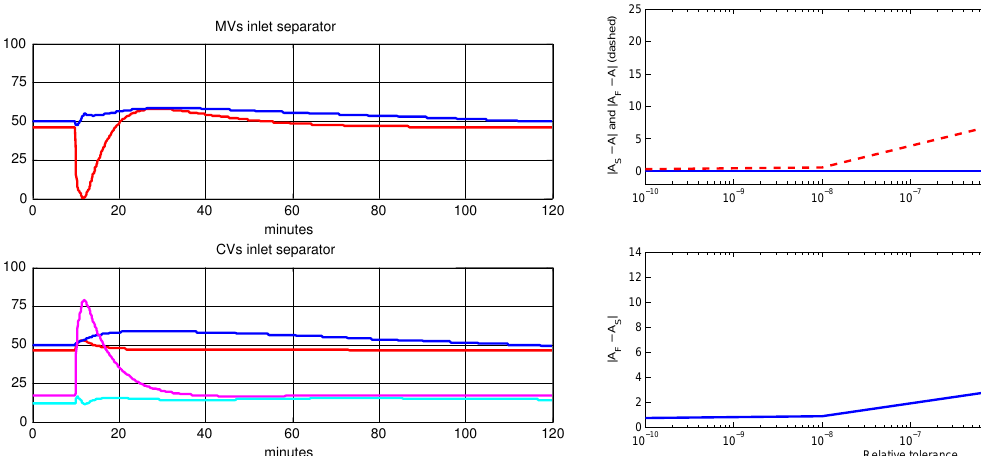
Figure 8: Top: Difference between ’real’ (as found by AS methods with tolerances of 1e-12) step re- sponse matrix A and step response matrices for higher tolerances. Bottom: Step response matrices using AS and AF (almost) converge as tolerances